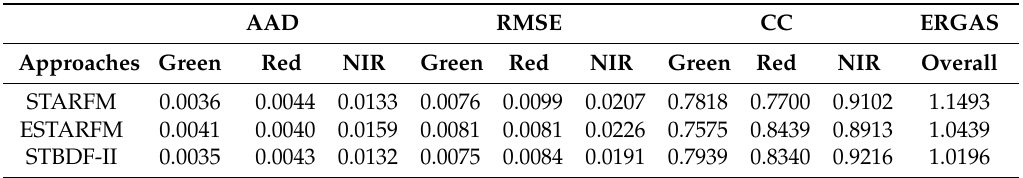
Figure 7. Scatter plots of the predicted reflectance against the actual reflectance. ( a – c ) Scatter plots of the predicted reflectance using STARFM, ESTARFM, and STBDF-II against the actual reflectance in the NIR band, respectively; ( d – f ) the red band; ( g – i ) the green band.